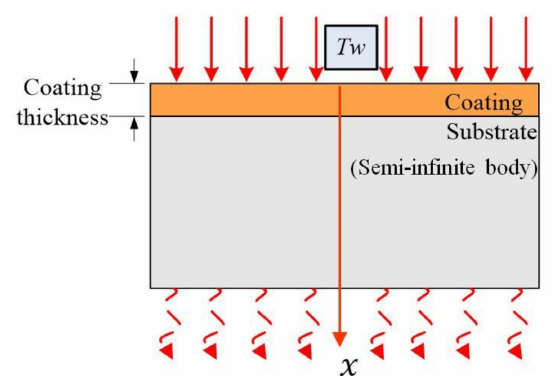
Figure 2. Schematic of one-dimensional heat conduction model of coated tools. For the modeling of proposed unsteady-state heat conduction, the following assump- tions are made to derive the mathematical modeling of the proposed unsteady-state heat conduction